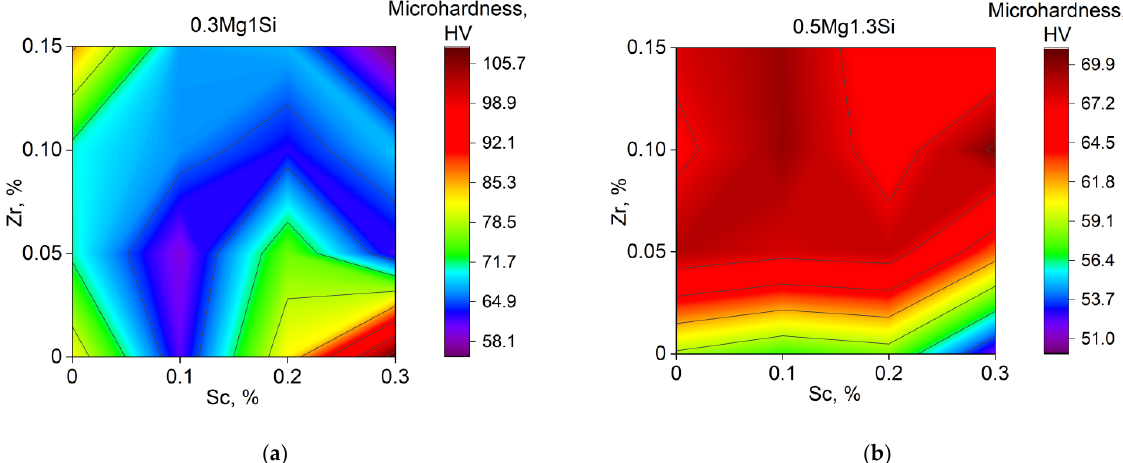
Figure 4. Microhardness with complex alloying with small additives Sc and Zr ( a ) in alloys based on Al 0.3 Mg 1 Si, ( b ) on Al 0.5 Mg 1.3 Si.